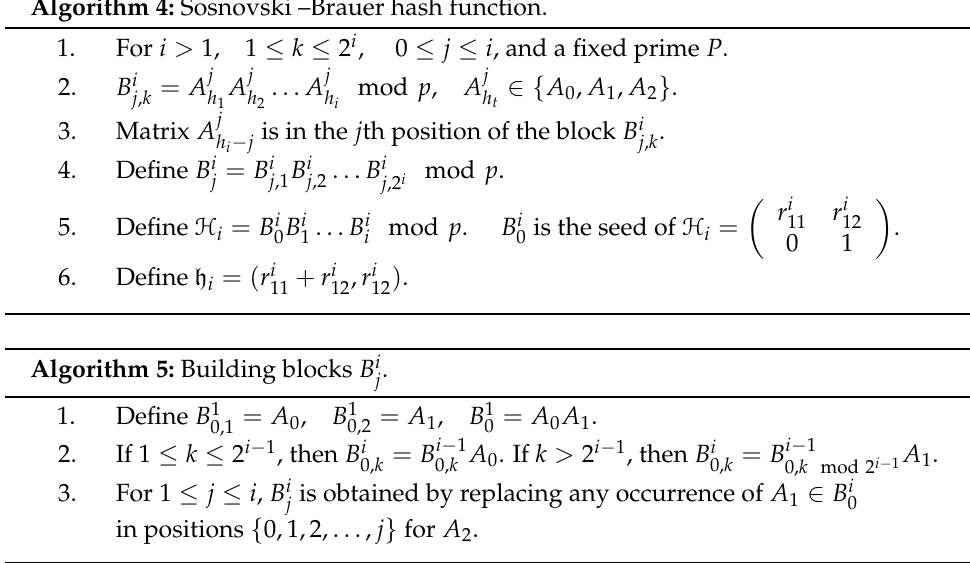
Algorithm 4: Sosnovski –Brauer hash function.